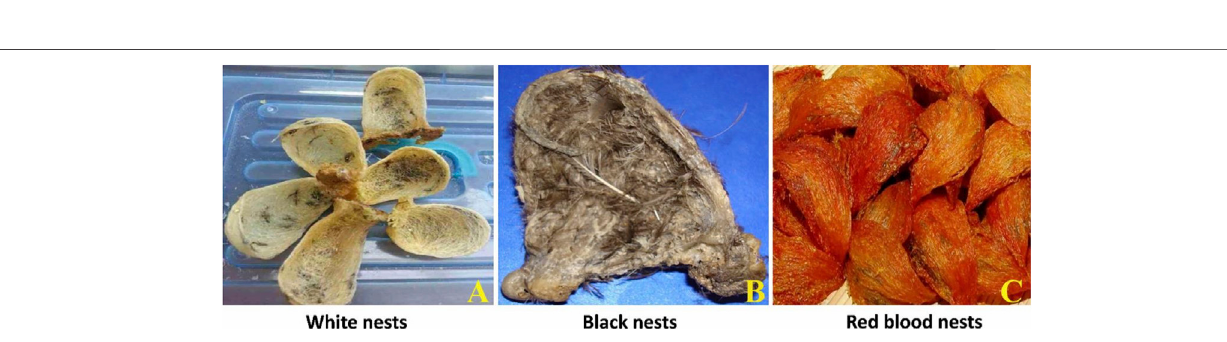
Frontiers in Pharmacology |